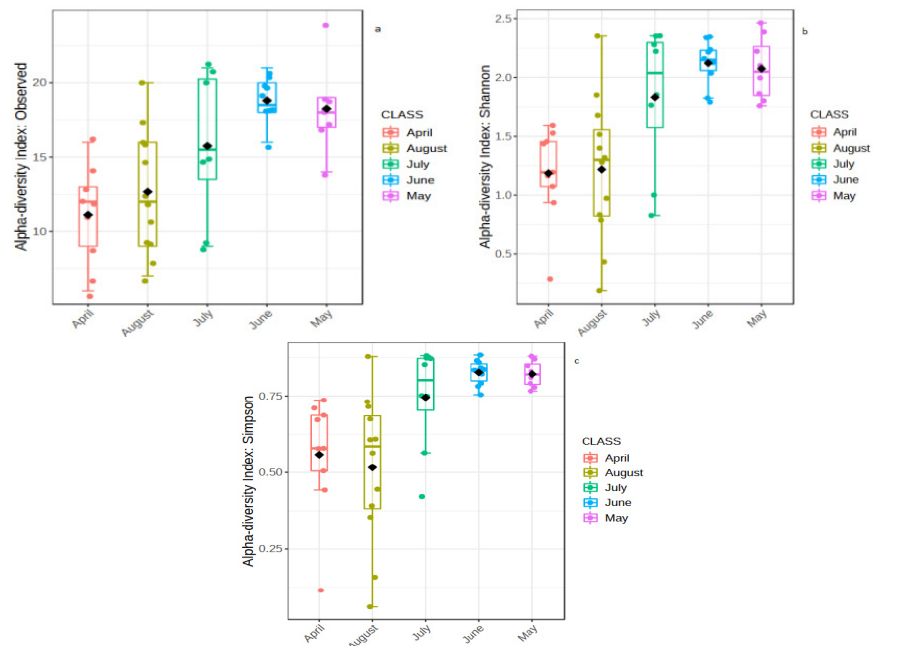
Figure 5. Alpha diversity measures at the OTU level are represented as boxplots for Lake Tana samples ( a – c ). Each boxplot represents the diversity distribution of a group present within the Months class. ( a ) Observed, ( b ) Shannon index and ( c ) Simpson index.